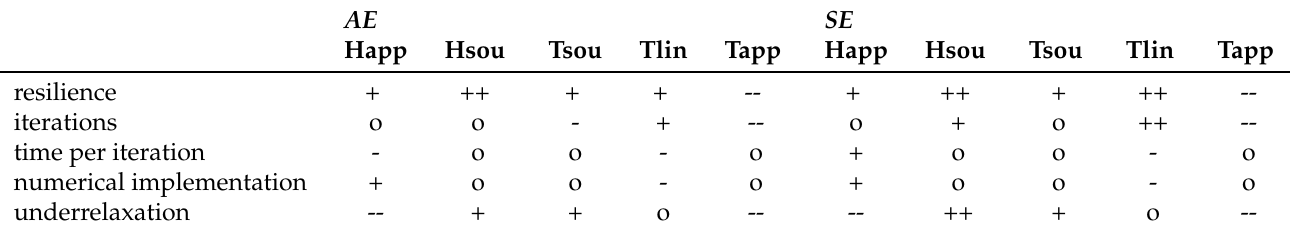
Table 5. Solver specific summary of the overall results including practical aspects. The characters indicate how the solvers perform in each area. The order is ++, +, o, - and --, where ++ is the most favorable